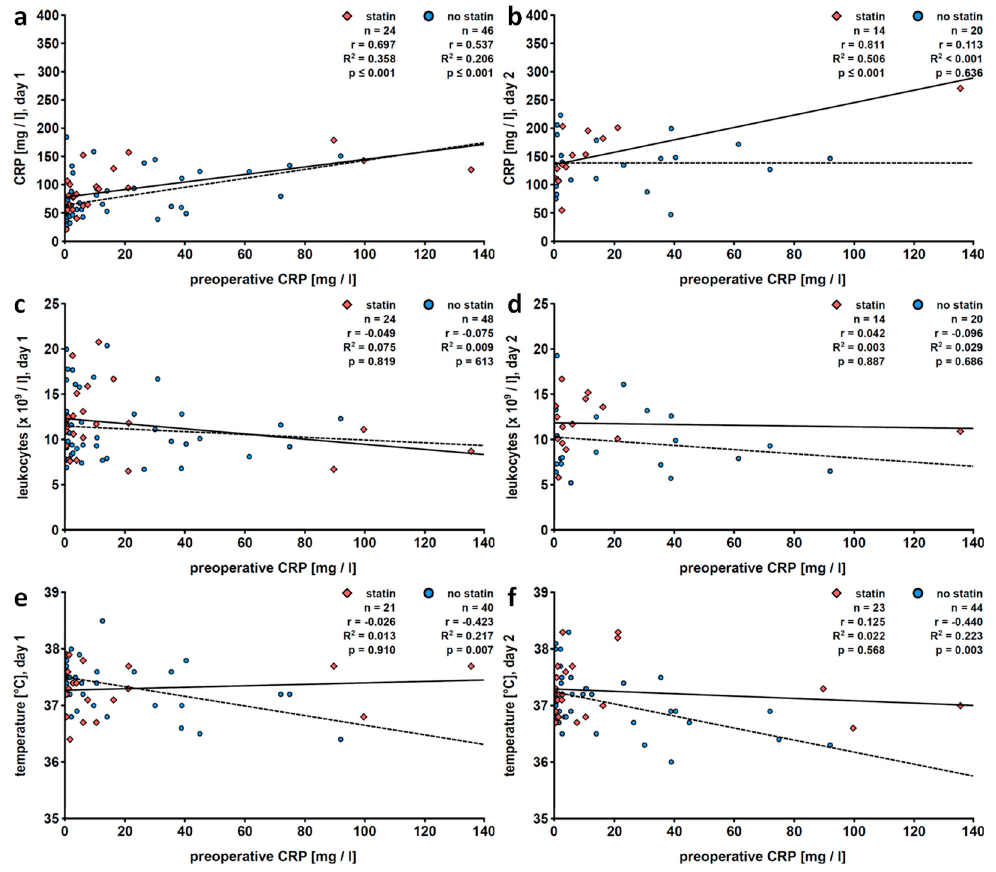
Figure 6. Female patients stratified according to statin intake: linear regression analyses of preoperative levels of C-reactive protein (CRP) with postoperative CRP levels ( a , b ), blood leukocyte counts ( c , d ) or fever ( e , f ). Patients who underwent pulmonary resection were investigated retrospectively and data collected on the first ( a , c , e ) and the second ( b , d , f ) postoperative day are depicted. Preoperative CRP values were obtained within 7 days before surgery. The solid line represents the best fit line for data patients treated with statins and the dashed line for those of patients who do not take statins. r, correlation coefficient; R 2 , coefficient of determination.